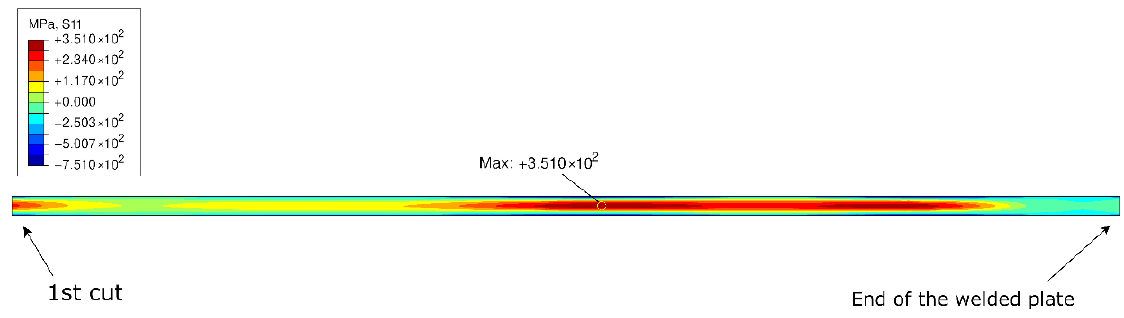
Figure 8. Transverse residual stress map in Vanadium insert using multiple cuts, asymmetric stiffness analysis, and superposition principle (stresses are in MPa).